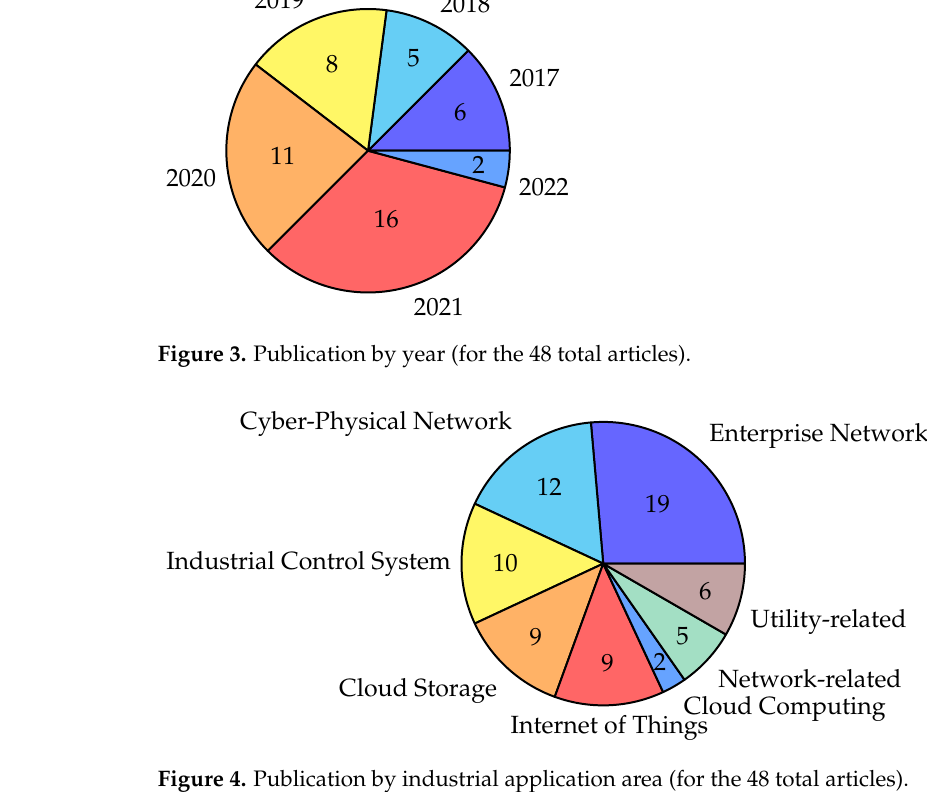
Figure 4. Publication by industrial application area (for the 48 total articles). Table 5. Publication country of origin aggregated by their year of publication (note: one publication may be attributable to multiple